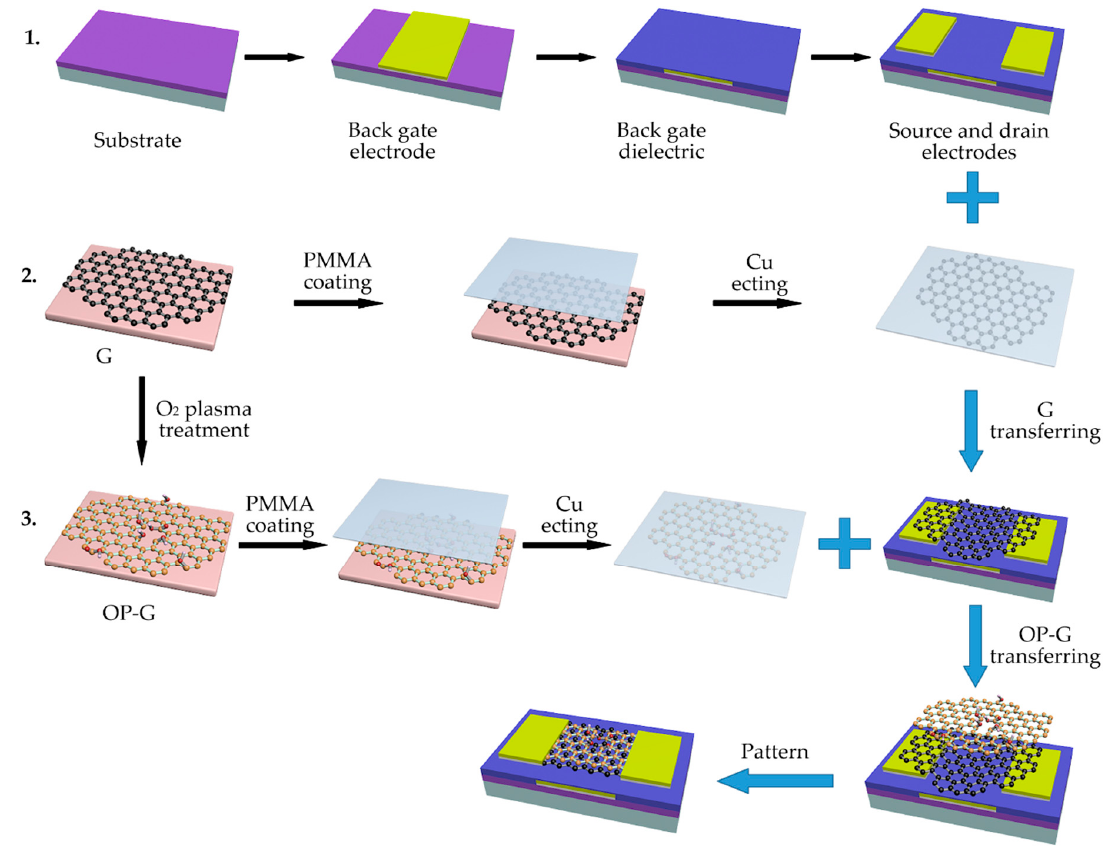
Figure 1. Schematic of the sensor fabrication process.